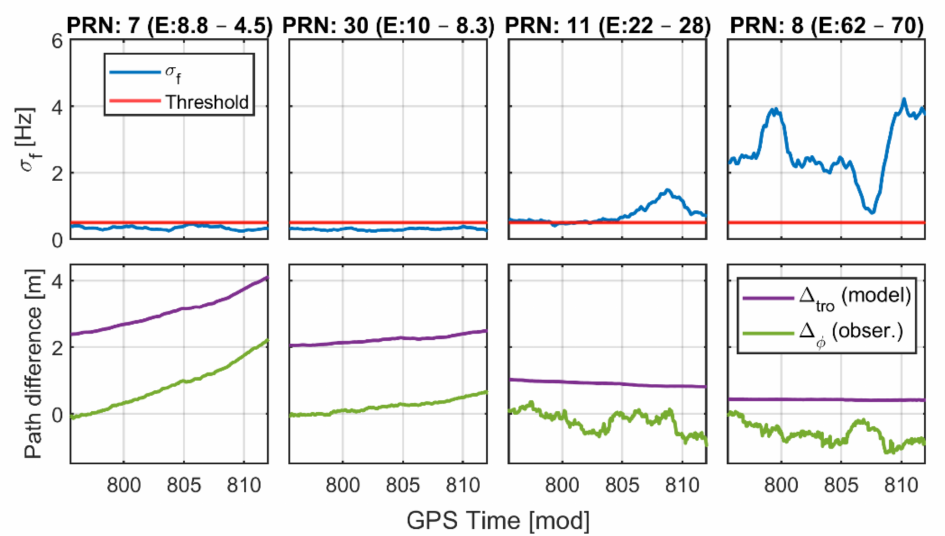
Figure 11. Doppler spread and tropospheric residual model compared with observed path difference from the residual phase on 17 July 2019. The satellite PRN number and the elevation angle range are indicated in the title of each column.